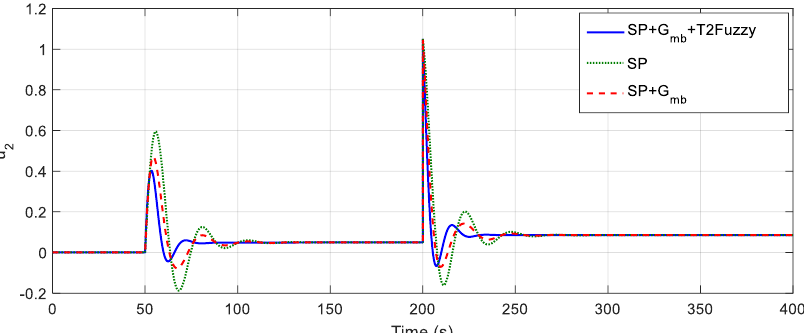
Figure 9. The control signal u 1 for all three methods for example 1.